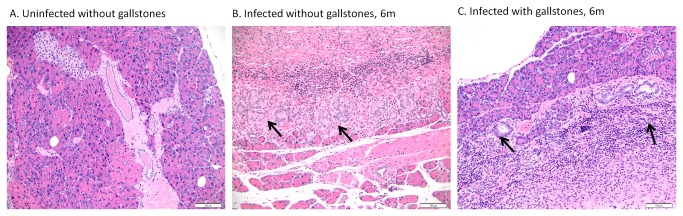
Pancreatic mucinous metaplasia was only evident in infected mice regardless of the presence of gallstones.Representative HE images of pancreas 6 months post-infection. Black arrows indicate mucinous metaplasia associated with exocrine pancreatic acini at the periphery of marked chronic necrosuppurative inflammation. 20x.